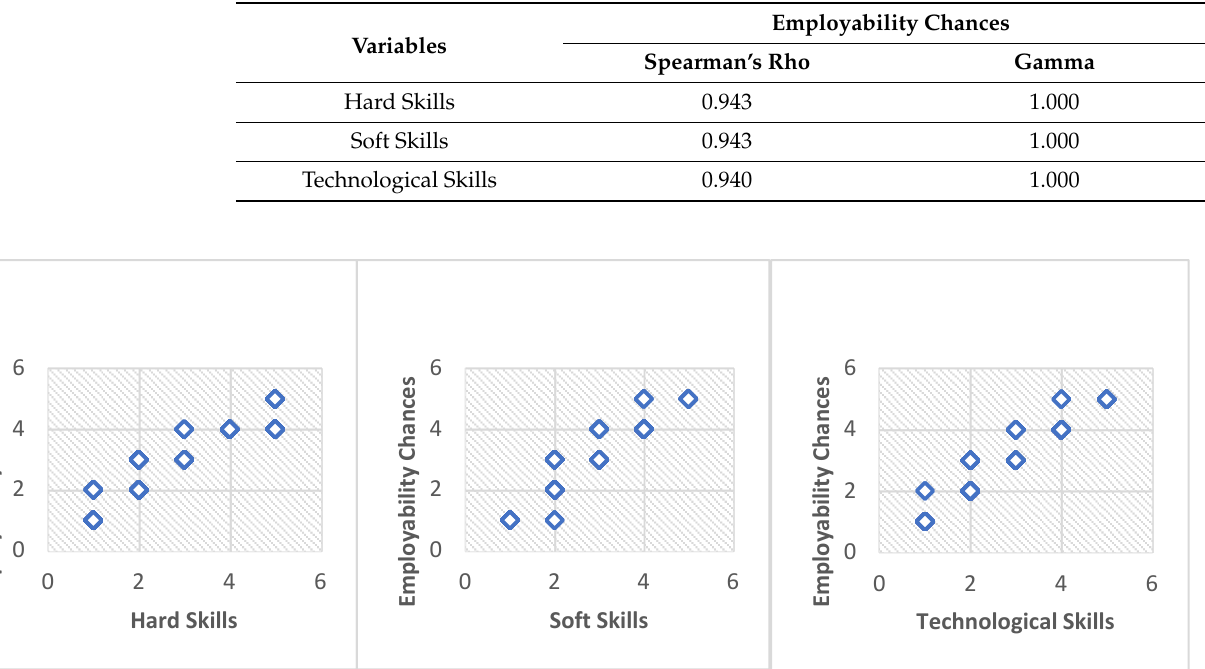
Figure 3. Frequency for the response for ‘is there existing mismatch between the current and require skills sets needed for graduate employability.’.